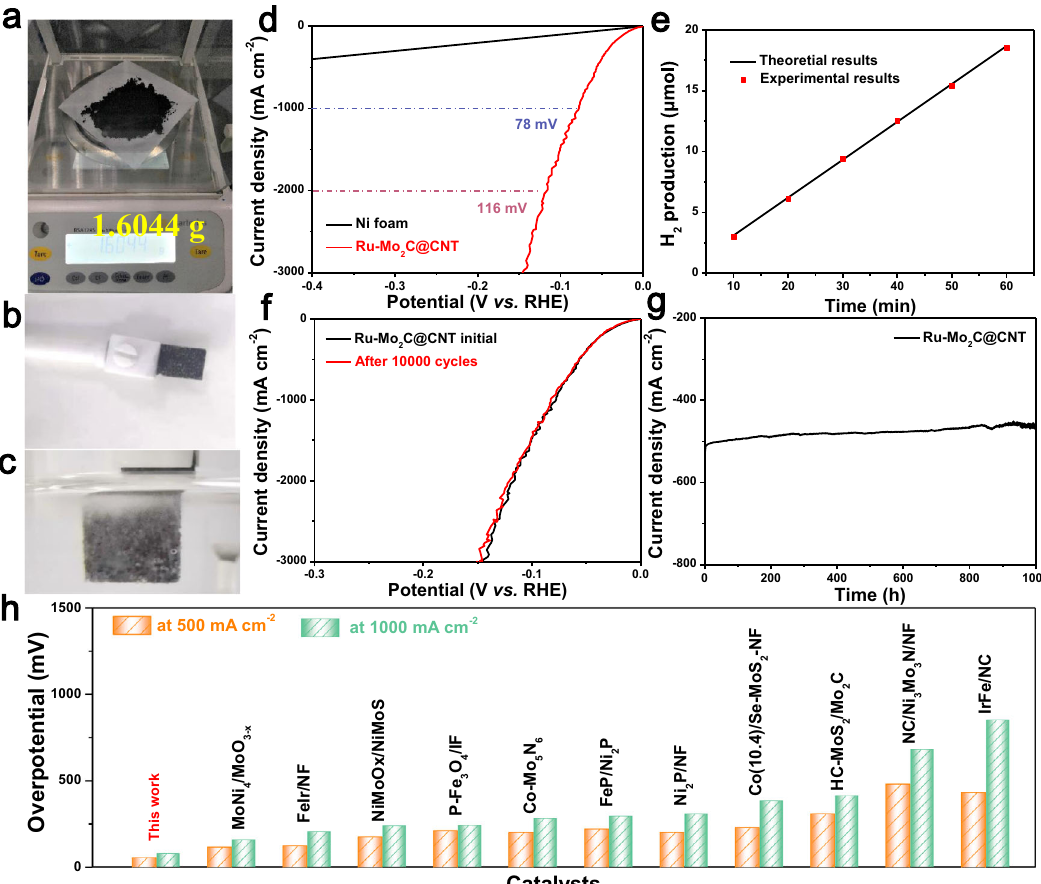
Fig. 4 Test of large-scale production of Ru-Mo 2 C@CNT catalyst for HER. a Photograph of catalyst output. b Photo of Ru-Mo 2 C@CNT catalyst directly drip-coated on the NF. c Photo of H 2 bubbles leaving the surface of Ru-Mo 2 C@CNT catalyst. d Polarization curves for Ru-Mo 2 C@CNT in 1.0 M KOH solution. e Theoretical and experimental results of H 2 production of Ru-Mo 2 C@CNT. f Polarization curves for Ru-Mo 2 C@CNT before and after 10,000 cycles. g The current-time (i – t) curve of Ru-Mo 2 C@CNT under the temporal evolution of the potential required to maintain 500 mA cm − 2 for 1000 h. h In 1.0 M KOH solution, comparison of the overpotentials at 500 mA cm − 2 and 1000 mA cm − 2 for the recent reported